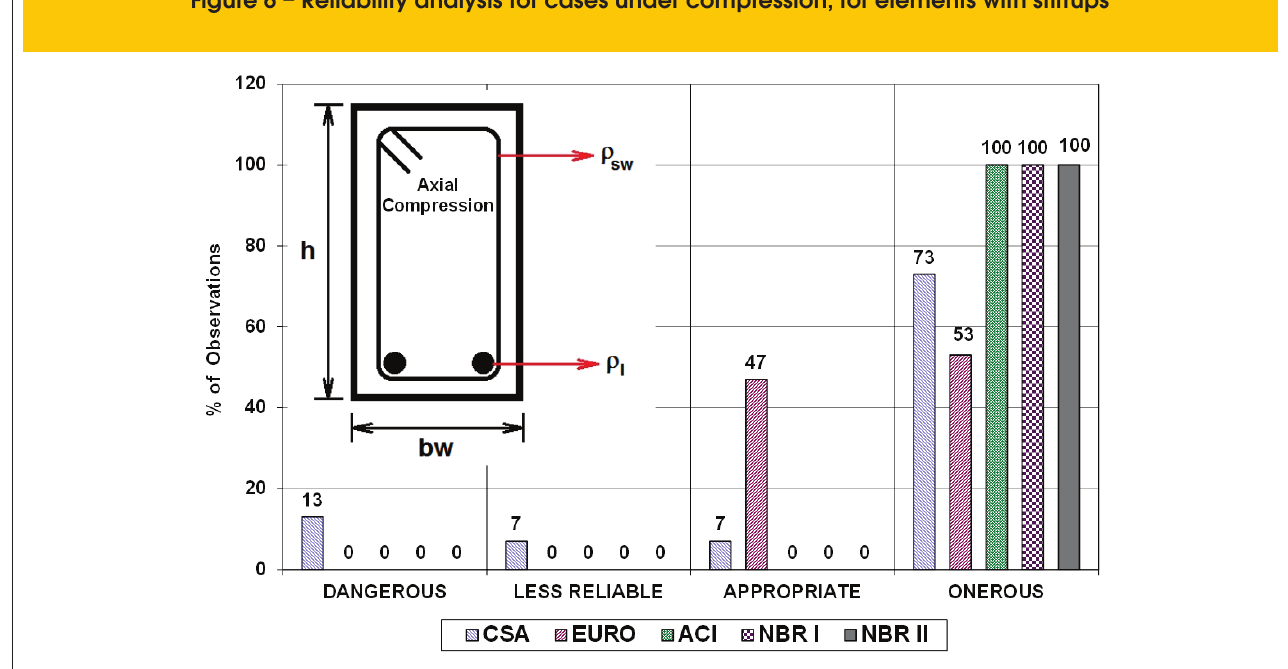
Figure 6 – Reliability analysis for cases under compression, for elements with